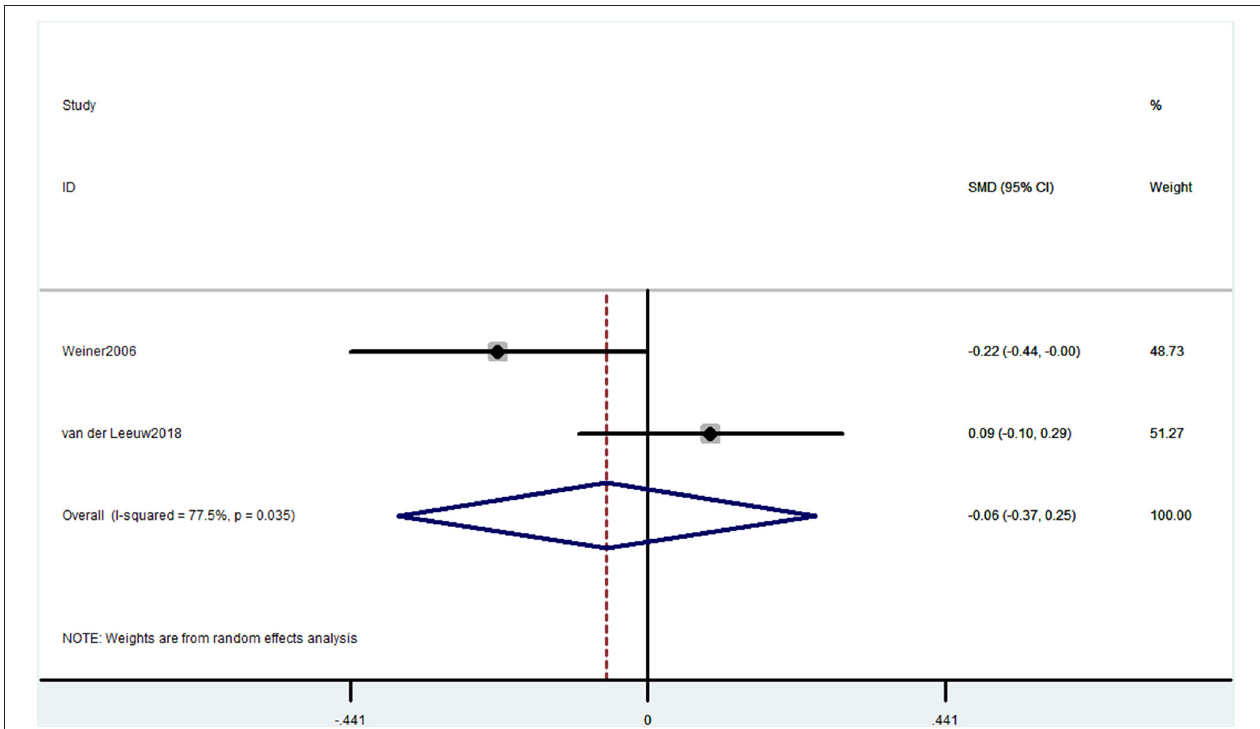
FIGURE 9 | Forest plot of the SMD and 95% CI from a random-effects meta-analysis for the association between chronic pain and incidence of cognitive decline when RBANS was used. The rhombi represent the pooled SMD for this